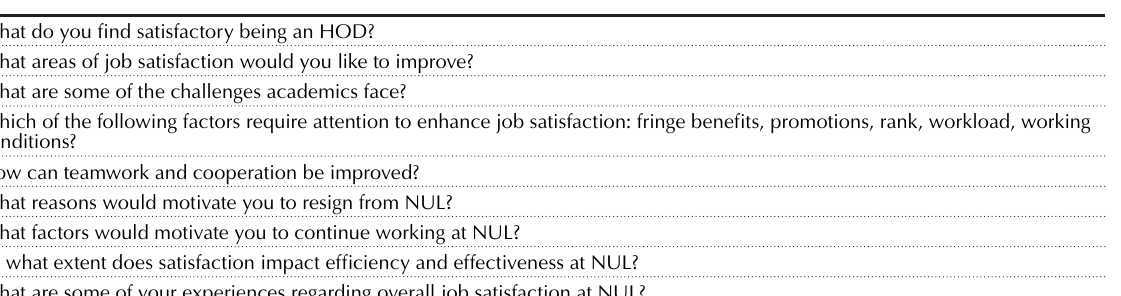
Table 2. Interview